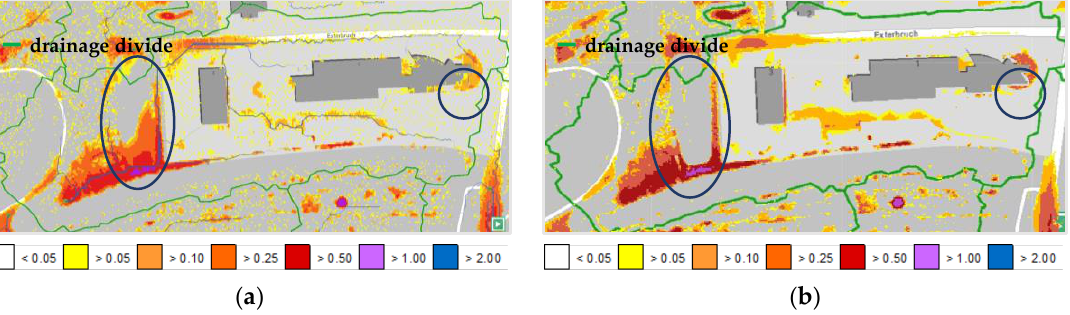
Figure 8. Predicted flood extent and depth after the precipitation: ( a ) reference flood map [30]; ( b ) simulation using acceleration solver, and the DEM-base roughness coefficient values.